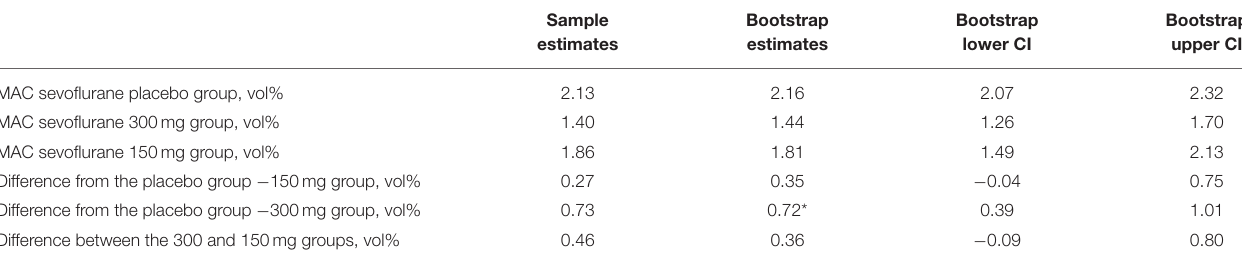
TABLE 2 | MAC estimates, 95% confidence intervals, and differences in the MAC between the study groups.